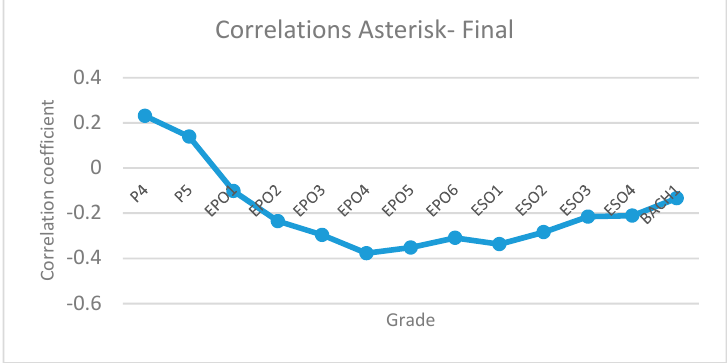
Figure 6. Correlation between the asterisk level and the final level per school grade.